Question: What caption would you write for this figure?
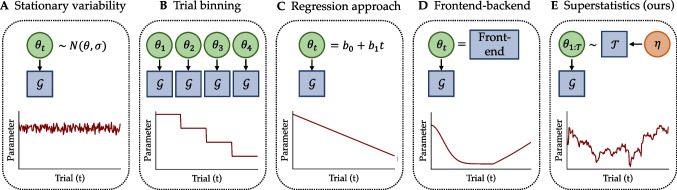
Answer: A conceptual illustration of the five main approaches to model temporal variation in the parameters \documentclass[12pt]{minimal} \usepackage{amsmath} \usepackage{wasysym} \usepackage{amsfonts} \usepackage{amssymb} \usepackage{amsbsy} \usepackage{mathrsfs} \usepackage{upgreek} \setlength{\oddsidemargin}{-69pt} \begin{document}$$\theta $$\end{document} θ of a cognitive model \documentclass[12pt]{minimal} \usepackage{amsmath} \usepackage{wasysym} \usepackage{amsfonts} \usepackage{amssymb} \usepackage{amsbsy} \usepackage{mathrsfs} \usepackage{upgreek} \setlength{\oddsidemargin}{-69pt} \begin{document}$$\mathcal {G}$$\end{document} G . A Stationary variability , also known as inter-trial variability, assumes that parameter values fluctuate around a stable mean. B Trial binning involves organizing the data into distinct bins and fitting a cognitive model \documentclass[12pt]{minimal} \usepackage{amsmath} \usepackage{wasysym} \usepackage{amsfonts} \usepackage{amssymb} \usepackage{amsbsy} \usepackage{mathrsfs} \usepackage{upgreek} \setlength{\oddsidemargin}{-69pt} \begin{document}$$\mathcal {G}$$\end{document} G to each bin individually. C Regression approach employs time (and sometimes additional contextual variables) as predictors for the parameters \documentclass[12pt]{minimal} \usepackage{amsmath} \usepackage{wasysym} \usepackage{amsfonts} \usepackage{amssymb} \usepackage{amsbsy} \usepackage{mathrsfs} \usepackage{upgreek} \setlength{\oddsidemargin}{-69pt} \begin{document}$$\theta $$\end{document} θ . D Frontend-backend models employ a mechanistic model, referred to as the frontend, to elucidate the dynamics of the parameter of the cognitive model (i.e., the backend). E Superstatistics involve a superposition of multiple stochastic processes operating on different temporal scales. They comprise a low-level observation model \documentclass[12pt]{minimal} \usepackage{amsmath} \usepackage{wasysym} \usepackage{amsfonts} \usepackage{amssymb} \usepackage{amsbsy} \usepackage{m